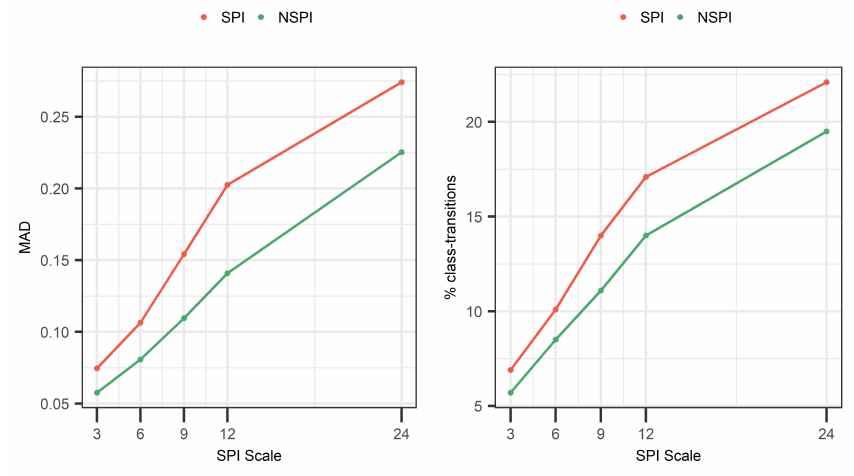
Figure 9. Mean absolute deviation ( left ), percentage of records with drought class transitions ( right ); for different scales of SPI and NSPI across